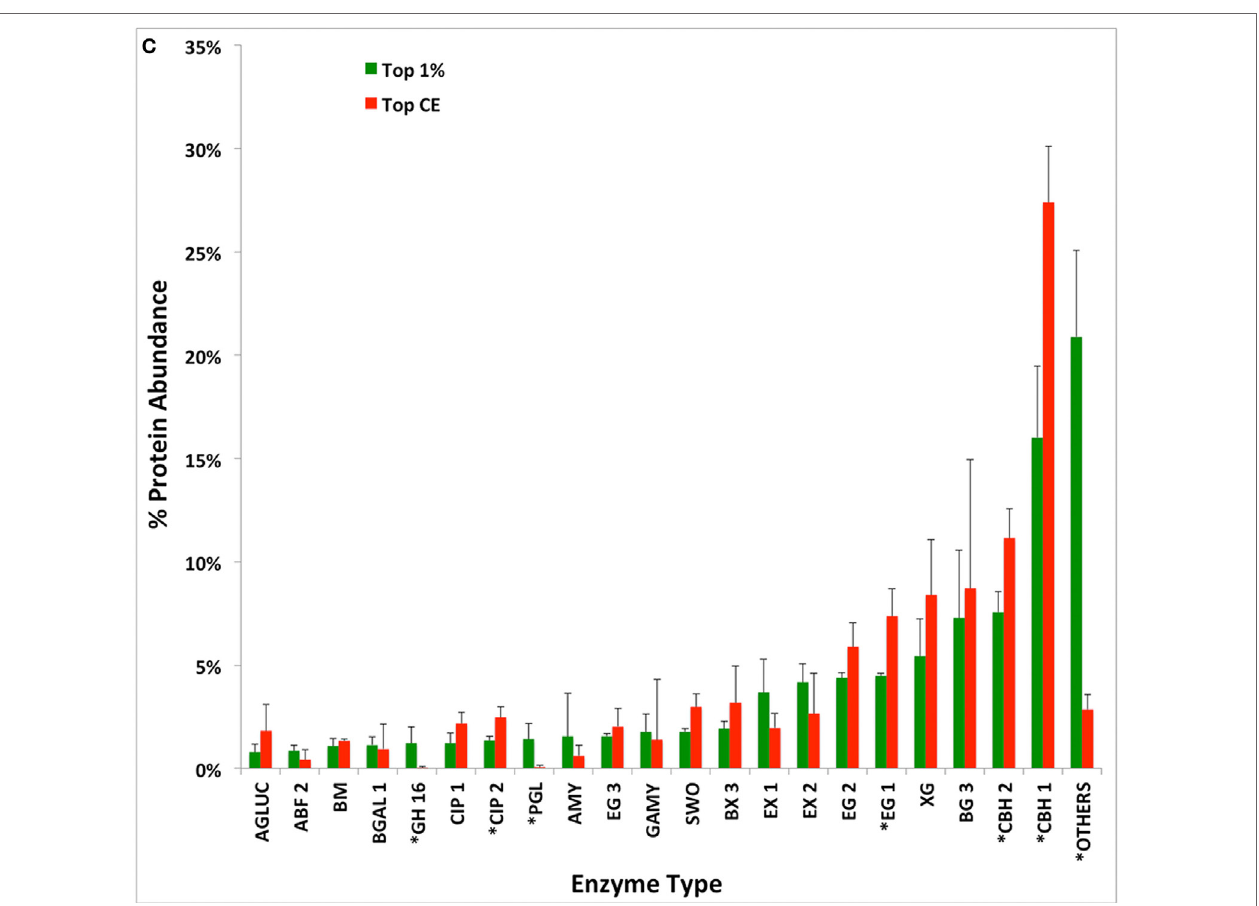
FigUre 7 | Total glucose and xylose yield (grams per kilogram of dry biomass) achieved as a function of various commercial enzyme (ce) combinations tested (a) . Average protein compositions of top 1% hits (giving maximum total glucose and xylose) from screening in (a) were compared versus the average protein composition of the leading CE blends CE1, CE6, and RE8 previously identified in the study (B,c) . Asterisks denote the significant difference in protein composition with p -value of 0.01 or lower between